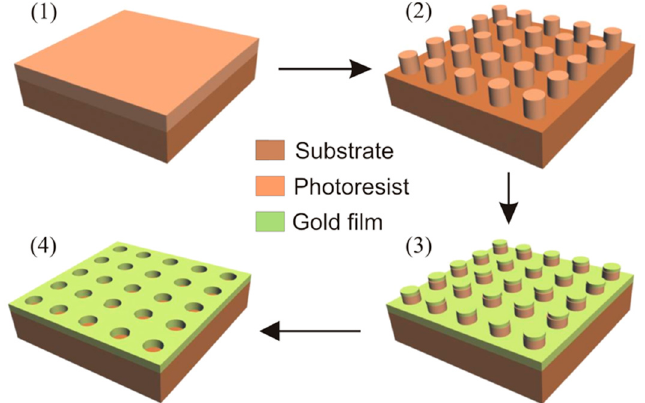
Figure 1. Scheme of nanohole array fabrication. (1) Photoresist deposition by spin coating, (2) double exposure of two-beam interference patterns using λ = 458 nm followed by photoresist development. (3) Au film deposition by thermal evaporation and (4) lift-o ff of the photoresist template.